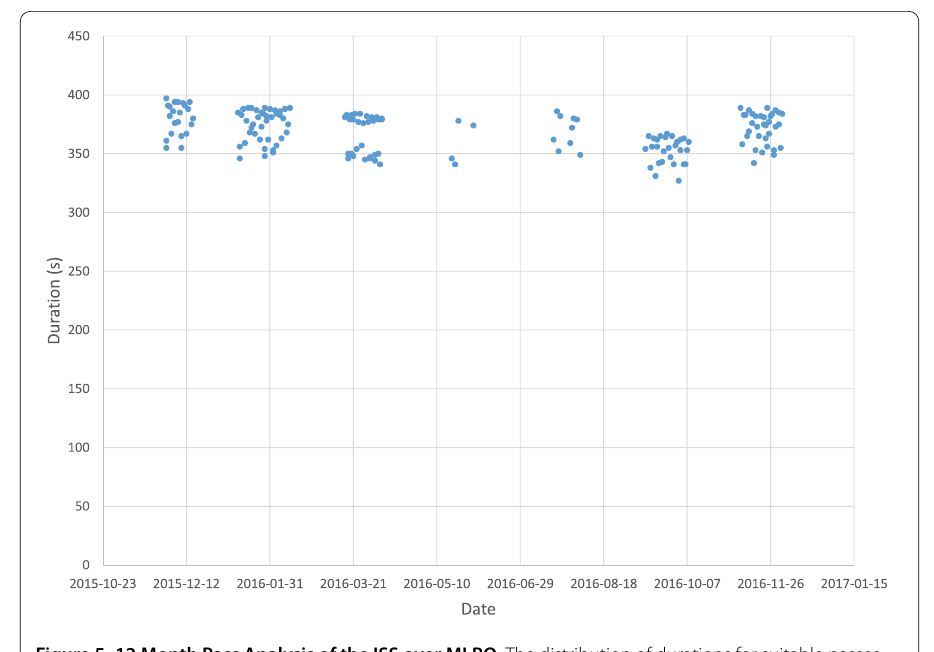
Figure 5 12 Month Pass Analysis of the ISS over MLRO. The distribution of durations for suitable passes over the OGS is shown. Passes were restricted to orbits rising at least 30 ◦ above the horizon and occurring in eclipse. The pass duration is counted as the time spent above 10 ◦ above the horizon though the actual time available for quantum transmission will be less than